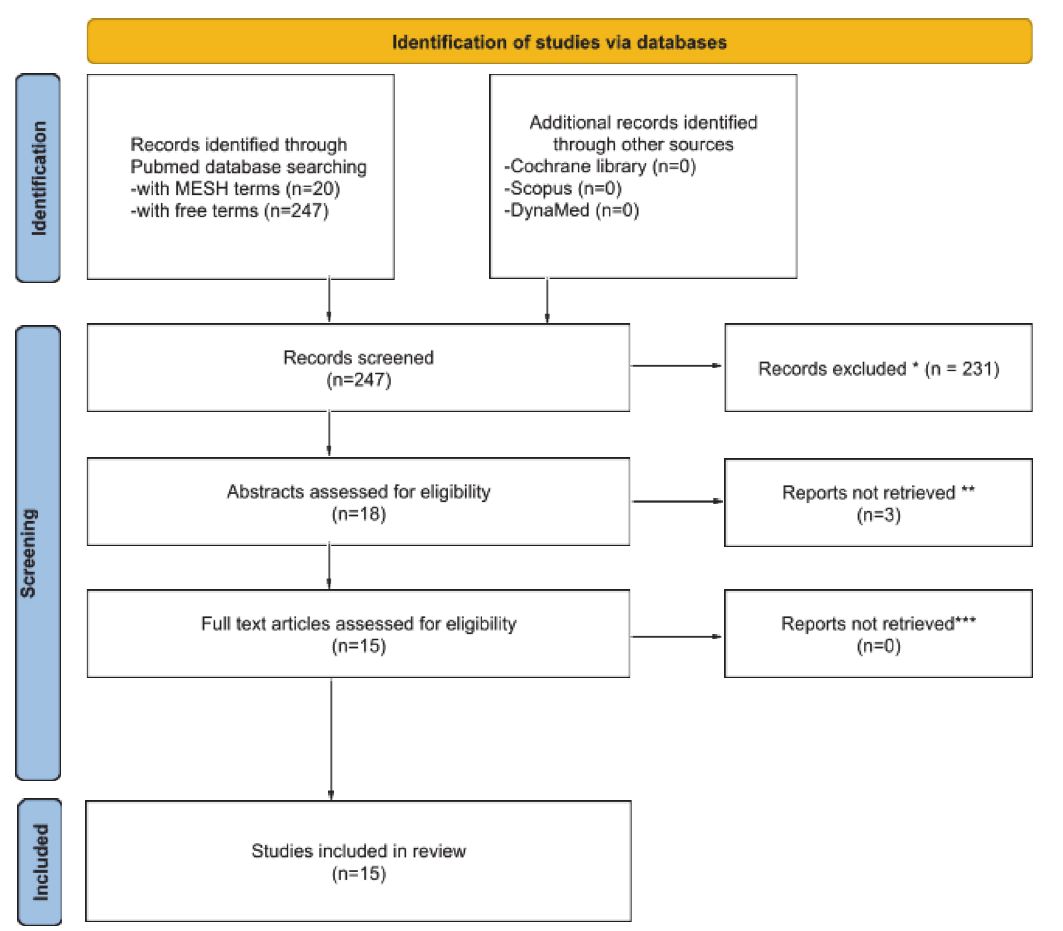
Figure 1. PRISMA flow diagram for literature research (Cochrane library, Scopus and DynaMed) up to November 2022.